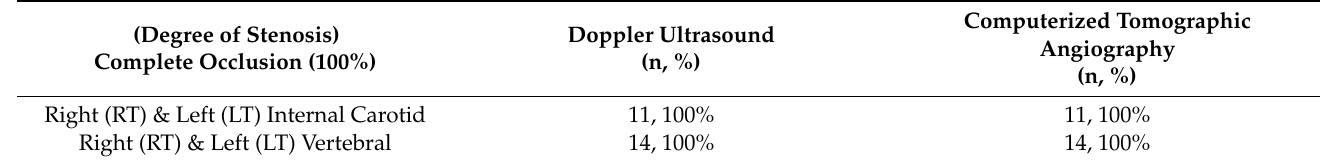
Table 4. Comparison of the complete occlusion in the carotid and vertebral arteries by Doppler Ultrasound (DUS) and Computerized Tomographic Angiography